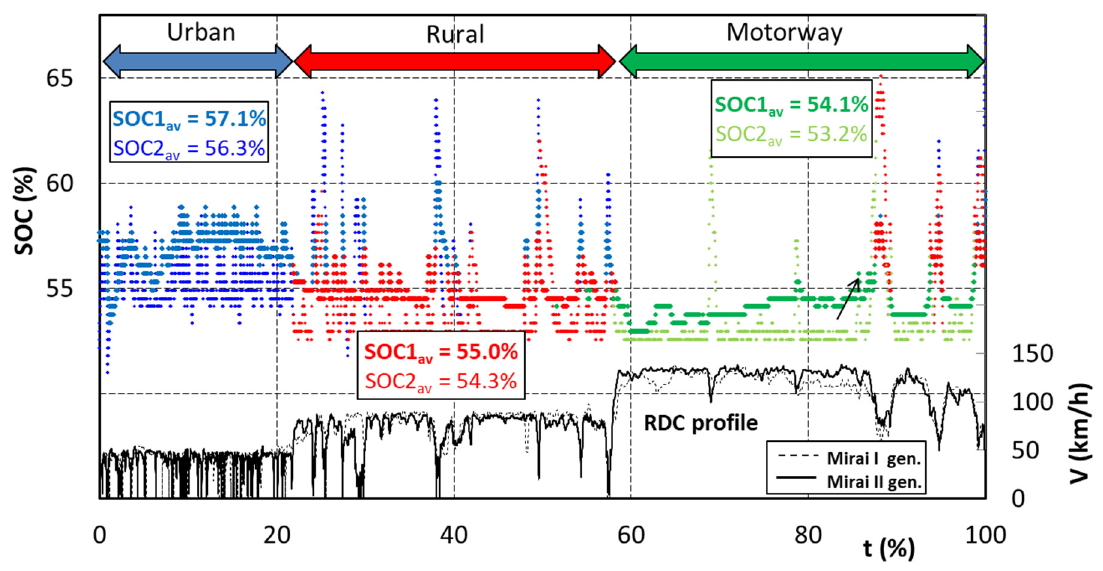
Figure 7. The batteries SOC changes against the speed profiles of both generations of Toyota Mirai (bigger dots—first generation; smaller dots—second generation).